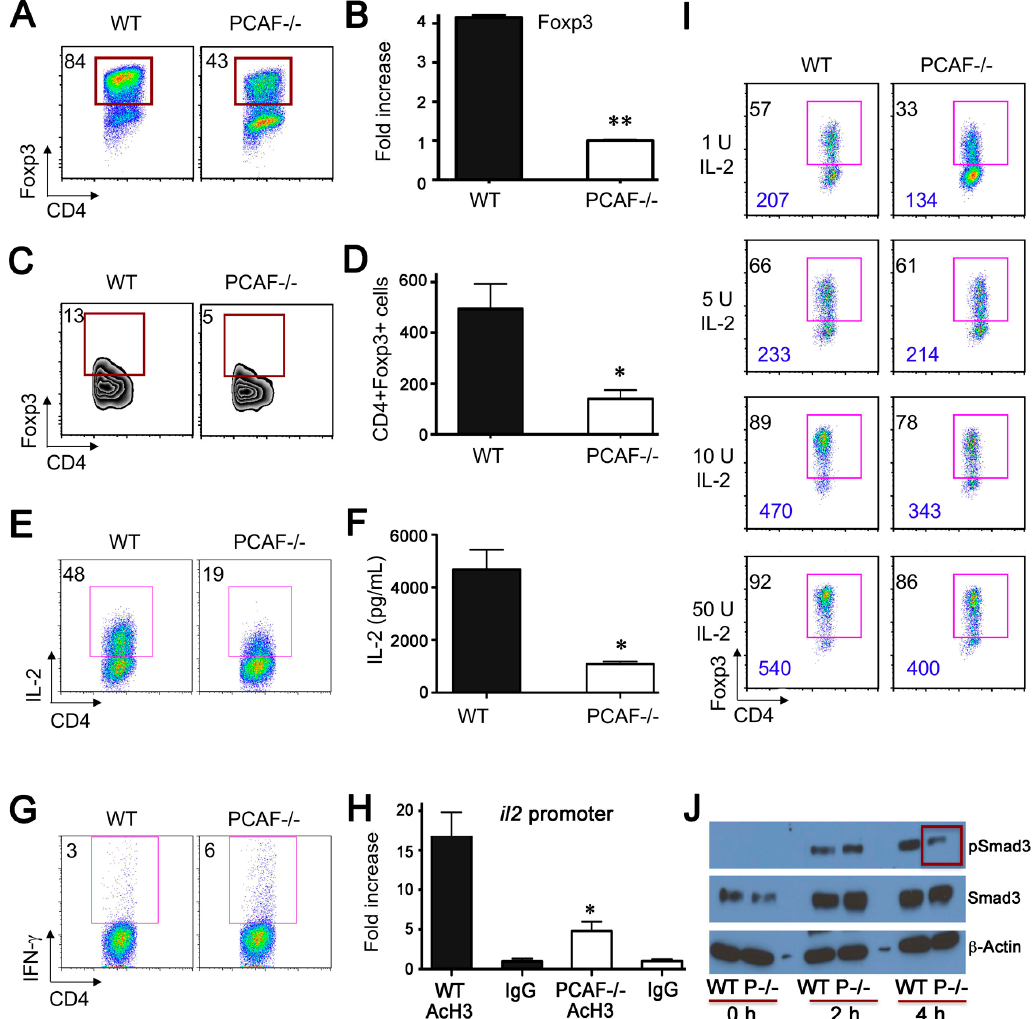
Figure 3. PCAF targeting in WT mice impairs inhibits Treg function in vitro and in vivo. ( A ) Sorted naïve CD4+CD44 lo CD62L hi CD25 − T cells were stimulated with CD3/CD28 mAb-coated beads, IL-2 and TGF β for 3 days; percentages of CD4+Foxp3+ Tregs are shown (* p < 0.05, Figure S7). ( B ) qPCR analysis of Foxp3 mRNA expression using sorted CD4+CD44 lo CD62L hi CD25 − naïve T cells stimulated with CD3/CD28 mAb-coated beads, IL-2 and TGF- β for 1 day; ** p < 0.01. ( C , D ) Sorted CD4+CD25 − CD44 lo CD62L hi naïve T cells (2 × 10 5 ) from WT or PCAF/- were adoptively transferred i.v. to B6/Rag1 − / − mice for 3 weeks. Spleens were harvested and ( C ) CD4+Foxp3+ percentages and ( D ) absolute numbers determined; * p < 0.05. ( E , F , G ) CD4+ T cells were isolated from WT and PCAF − / − mice and stimulated with CD3/CD28 mAb-coated beads for 24 h, followed by ( E ) intracellular staining of IL-2, ( F ) measurement of supernatant IL-2 protein by ELISA (* p < 0.05), and ( G ) intracellular staining of IFN- γ . ( H ) CD4+ T cells were isolated from WT and PCAF − / − mice and analyzed by ChIP-qPCR assay for the levels of acetyl-H3 at the il2 promoter (* p < 0.05). ( I ) Percentages of CD4+Foxp3+ cells generated when varying amounts of IL-2 were added to the iTreg conversion conditions described in the legend for panel ( A ); MFI level is shown in blue. ( J ) Sorted CD4+CD44 lo CD62L hi CD25 − naïve T cells were stimulated with CD3/CD28 mAb-coated beads, IL-2 and TGF- β for the periods indicated, and cell lysates analyzed by western blotting. Data are representative of 3 independent experiments.